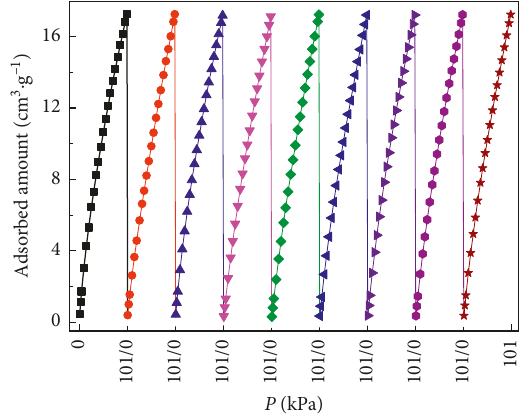
Figure 7: Adsorption and desorption cycles for CH